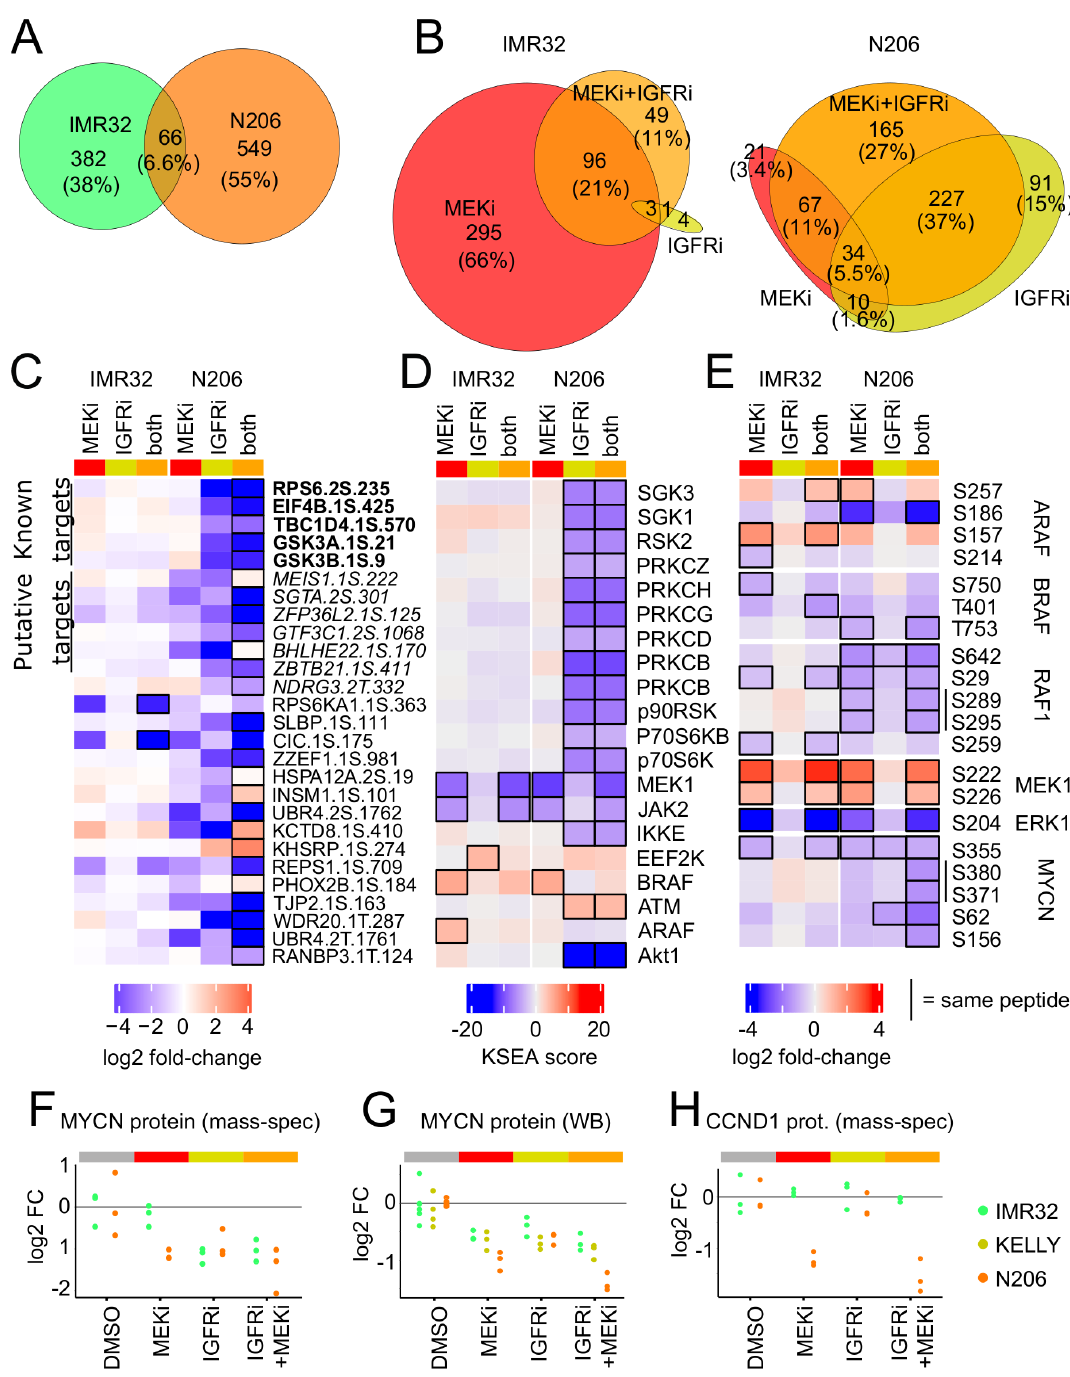
Fig 5. Phosphoproteomics analysis reveals important variations in the response to combination treatment. A-B: Venn diagrams showing the overlap in differentially regulated phosphosites A: between IMR32 and N206 or B: between treatments for each cell line. C: Phosphopeptides synergistically altered by MEKi+IGFRi combination (black outline) when compared to the sum of individual inhibitor treatments. AKT, mTOR or P70S6K bona fide targets (bold font) and putative targets (italic font; top 5 predicted kinases by PhosphoNET Kinase Predictor www.phosphonet.ca) are indicated. D: Kinase substrate enrichment score using PhosphoSitePlus annotations. E: Log-fold change to DMSO for RAF/MAPK and MYCN phosphopeptides. C-E: Black outline highlights significant changes in activity (limma moderated t-test, FDR < 5%) F-H: Relative levels compared to control of the total proteins levels for MYCN (F) and CCND1 (H) measured with mass spectrometry and MYCN measured with Western blot (G).